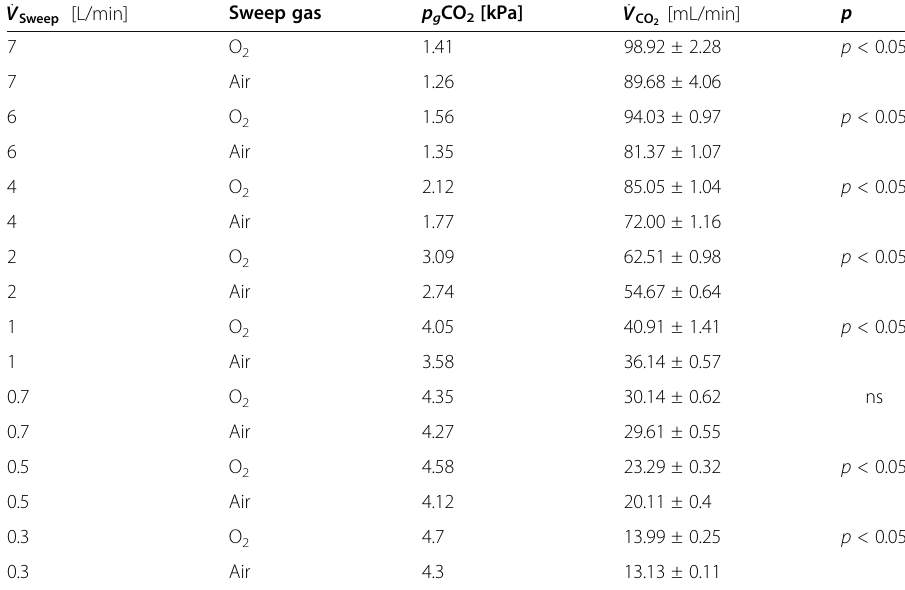
Table 1 Impact of pure oxygen and air as sweep gases on CO 2 removal ˙ V Sweep [L/min]